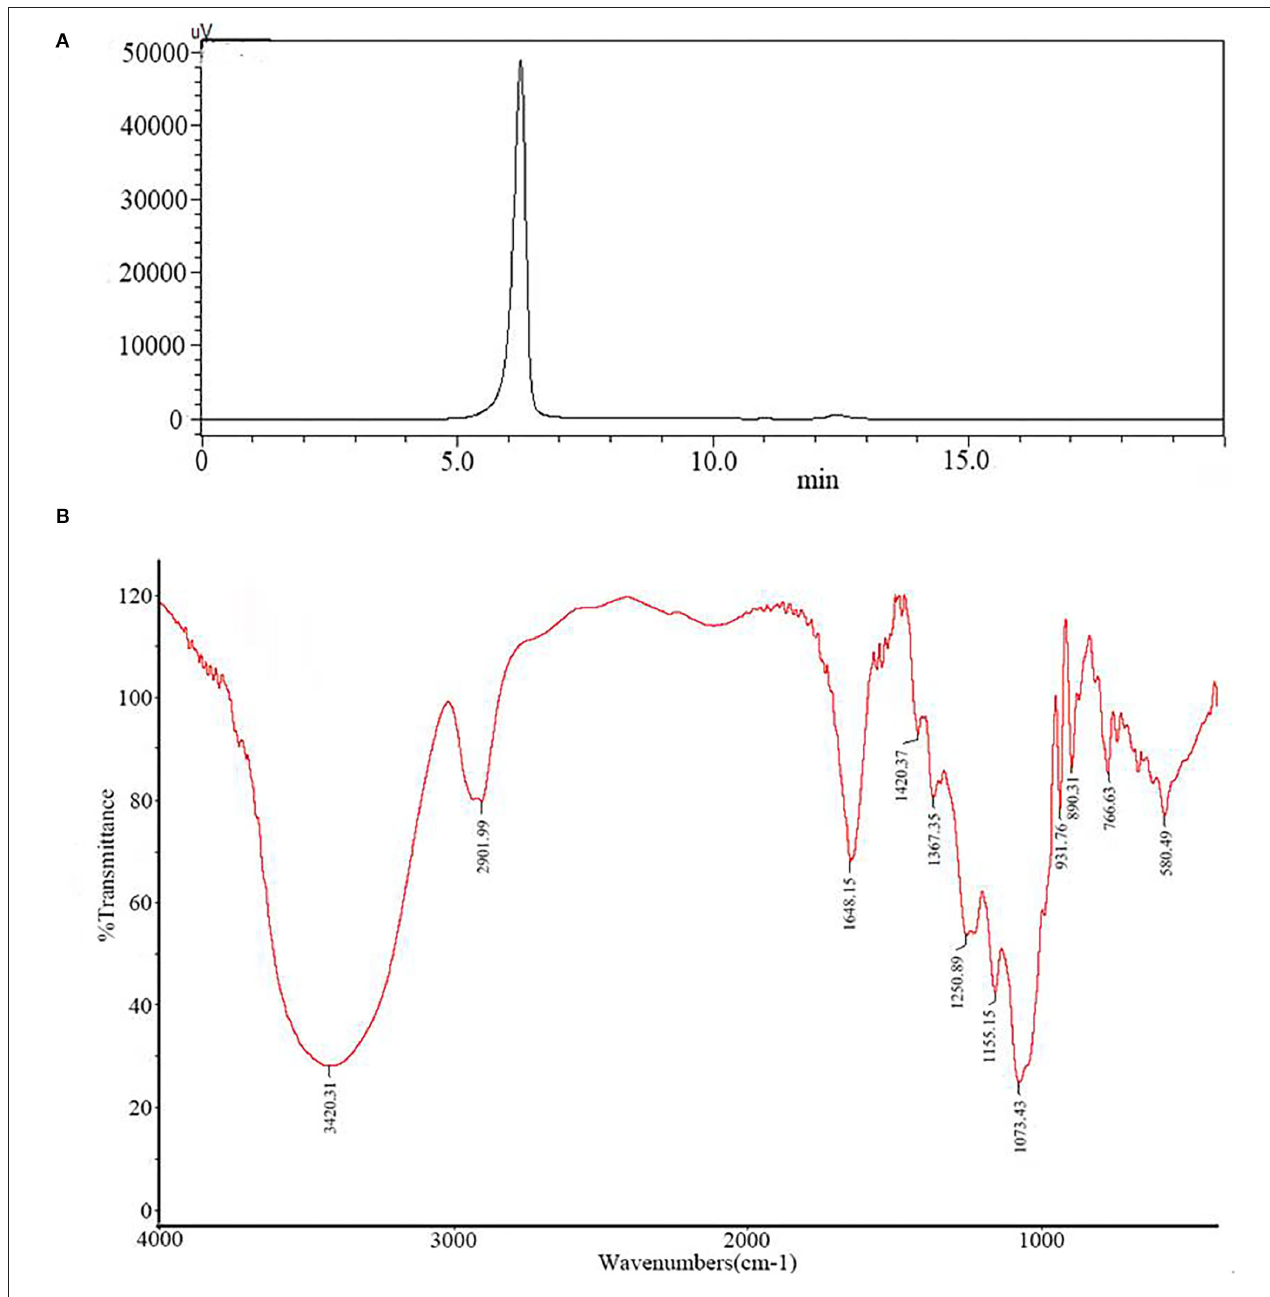
FIGURE 1 | The molecular weight distribution (A) and infrared spectrum (B) of